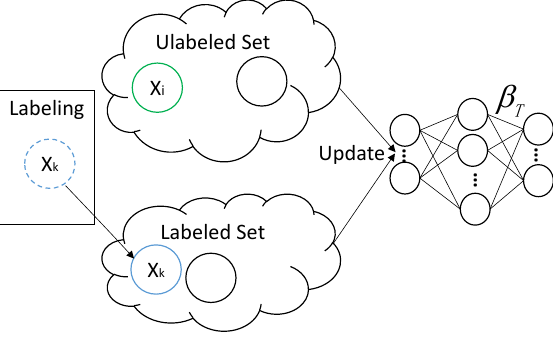
Figure 6. Labeled incremental